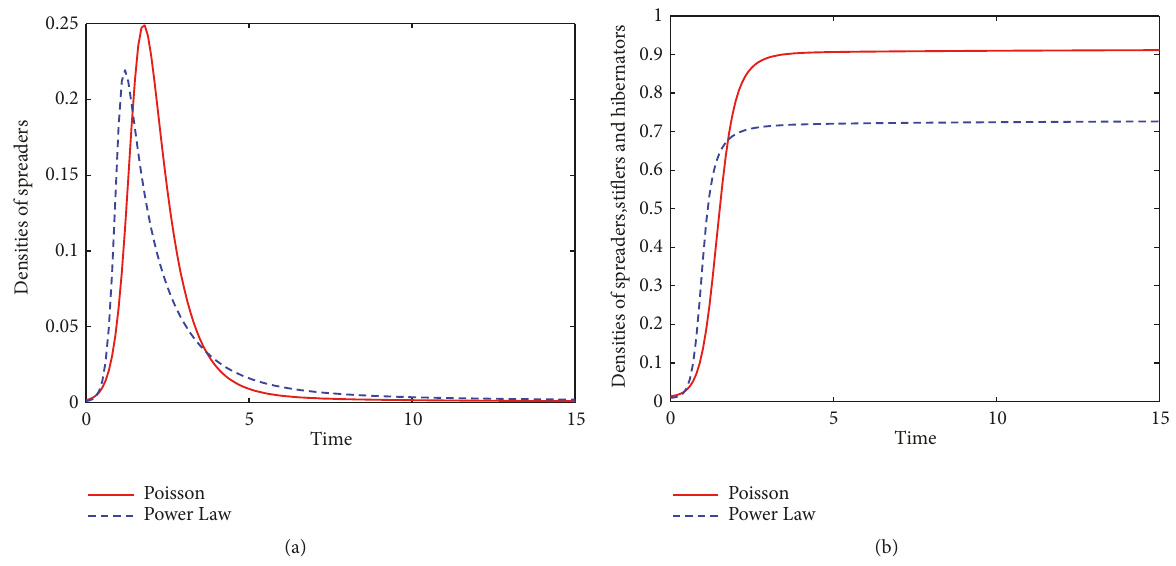
Figure 5: Numerical simulations of (3) with 𝜆 = 0.7 , 𝛽 = 0.3 , 𝛼 = 0.2 , 𝛿 = 0.1 , 𝜉 = 0.1 , 𝜂 = 0.1 in the networks with different degree distributions butwith the same averageddegree. Thered solid linesand the bluedashed lines correspondtonumericalsimulations trajectories for an SIHR rumor model (3) in a network with the Poisson degree distribution and the refined power-law degree distribution, respectively. (a) The trajectories of the densities of spreaders. (b) The trajectories of the densities of spreaders, stiflers, and hibernators.